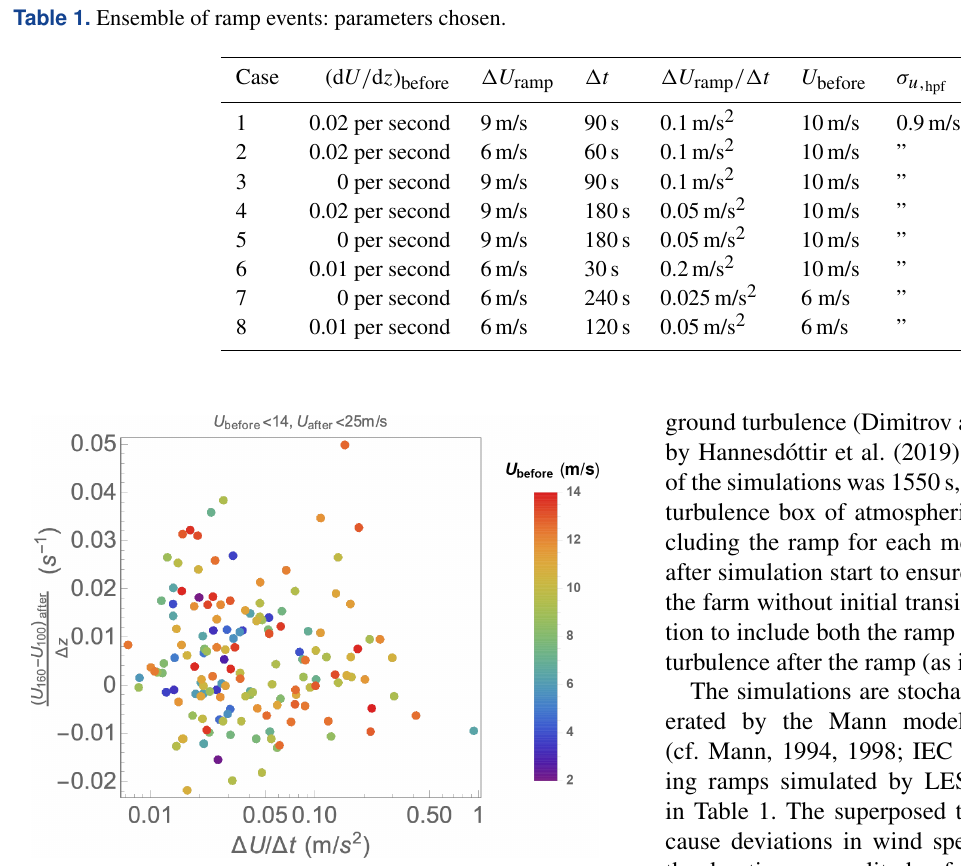
Figure 8. Detected ramp events: upper-level shear after event, ramp acceleration, and wind speed before